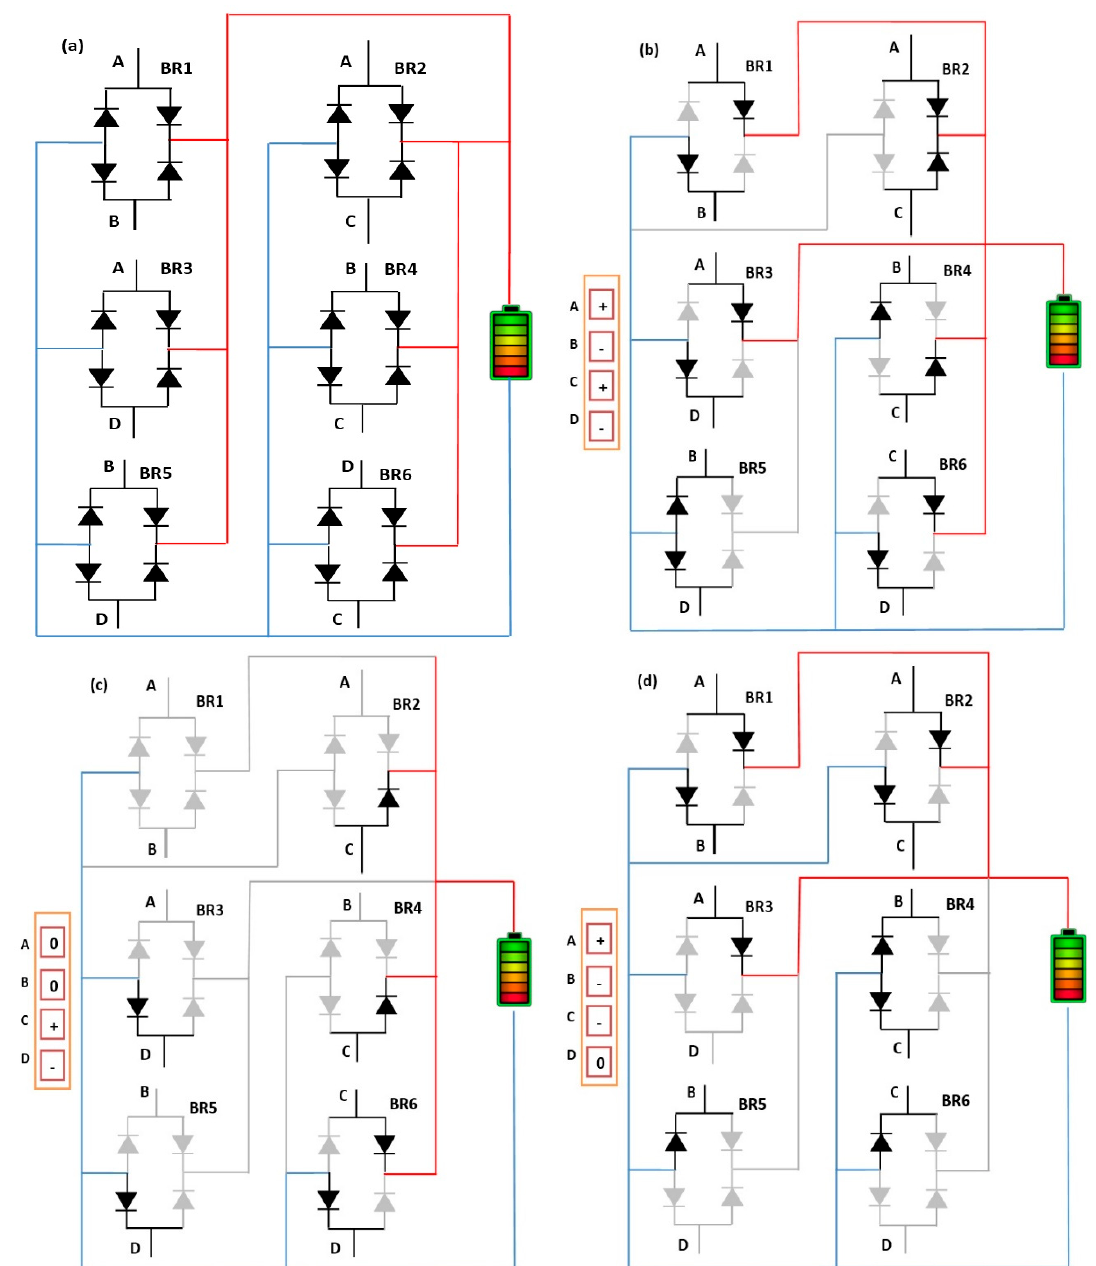
Figure 3. The proposed on-board circuit with a contacted sample of the circuit with all connections which diode bridge rectifiers (BR1, BR2, BR3, BR4, BR5, BR6) connected to four contact pin (A, B, C, D) and have four example of operation cases represented in ( a ), two positive and two negatives in ( b ), one positive, one negative, and two disconnected in ( c ), one positive, two negatives, and one disconnected in ( d ). Table 1. The cases of charging conditions, where the four contact points and the two signals (positive and negative) are embedded in the truth table to review charging condition probabilities.